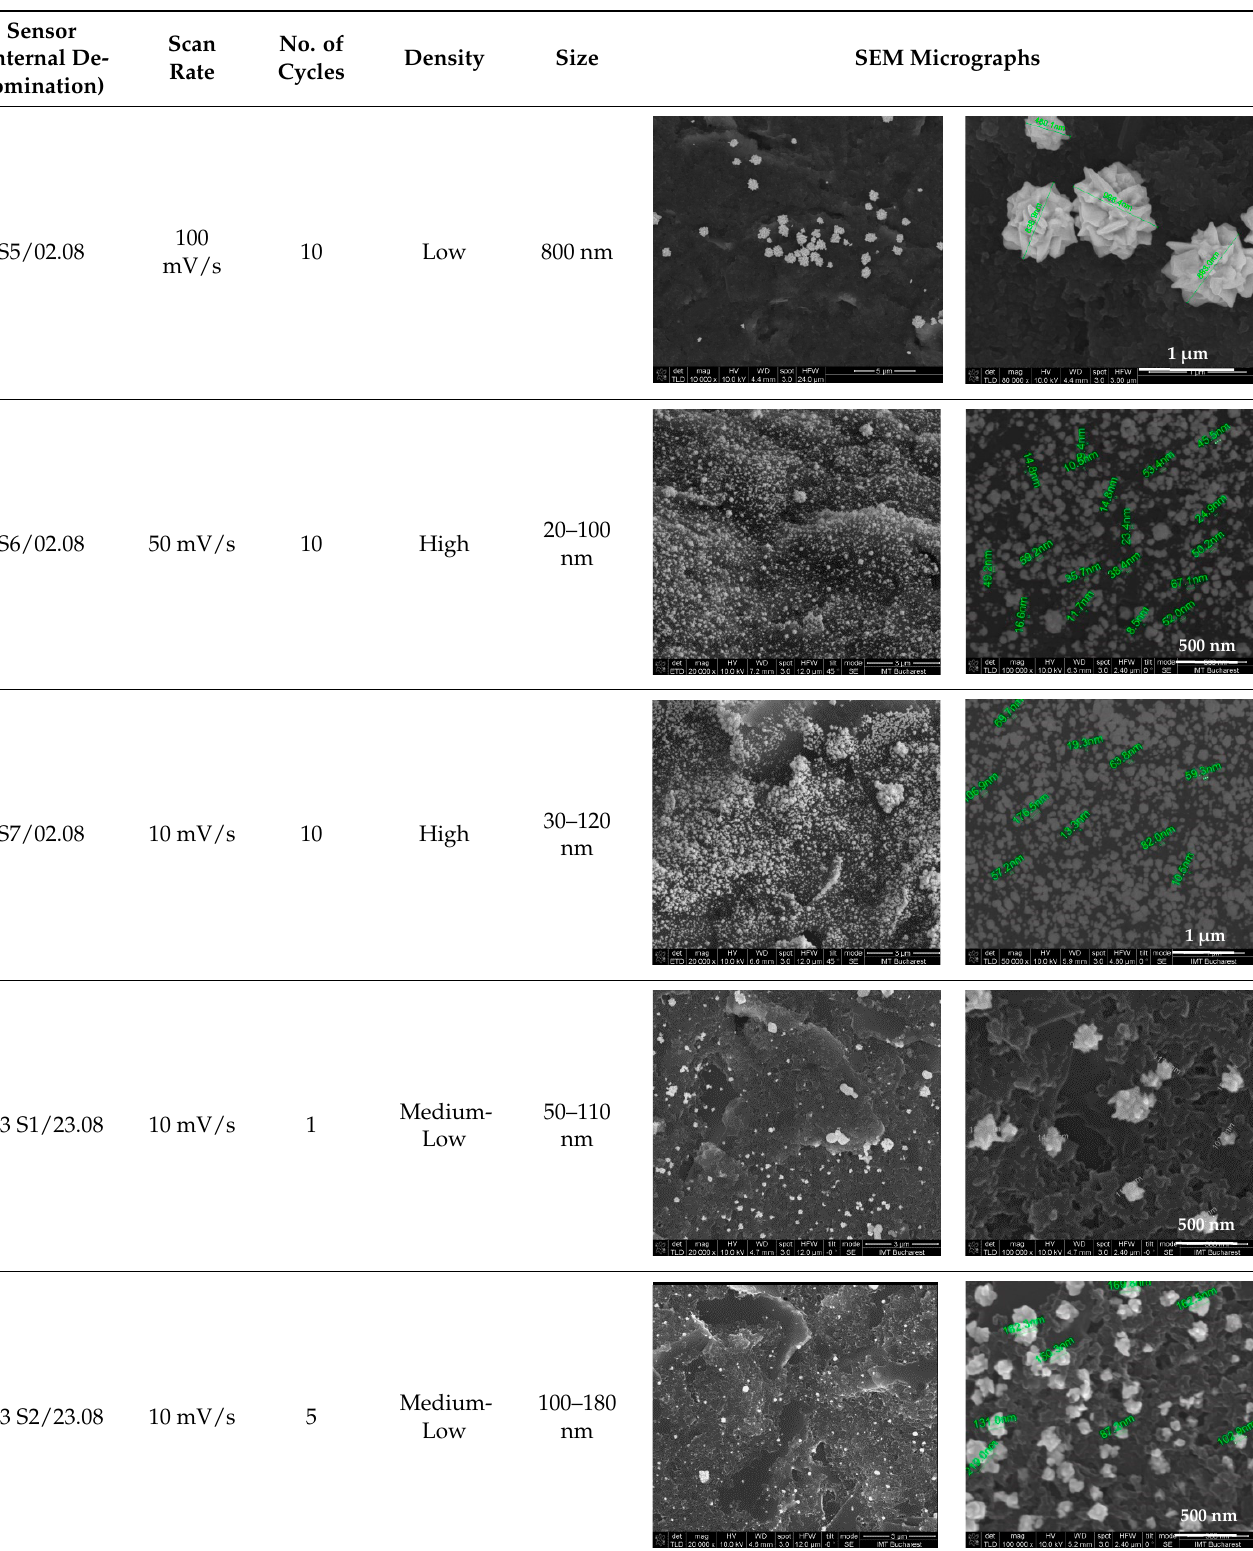
Table 1. In fl uence of di ff erent parameters on the AuNP electro-deposition.